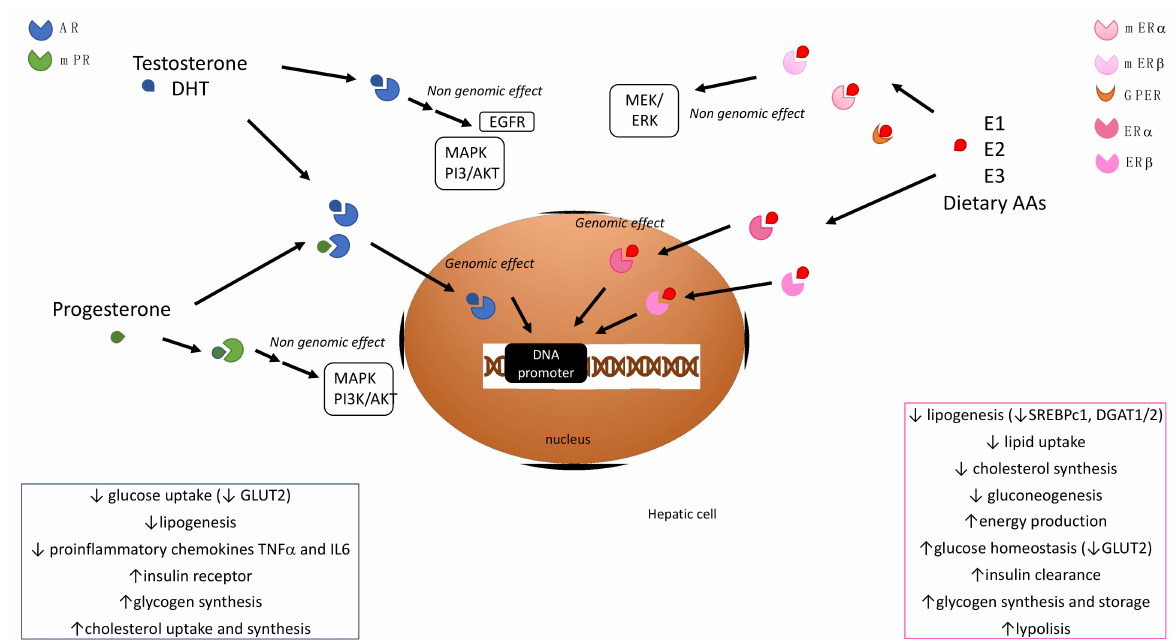
Figure 1. Main signaling pathways mediated by sex hormone receptors in hepatocytes and their physi- ological effects. AR, androgen receptor; mPR, membrane progesterone receptor; DHT, dihydrotestos- terone; MAPK, mitogen-activated protein kinase; PI3K/AKT, phosphatidylinositol 3-kinase/protein kinase B; EGFR, epidermal growth factor receptor; MEK/ERK, mitogen-activated protein kinase ki- nase/extracellular signal-regulated kinase; E1, estrone; E2, estradiol; E3, estriol; mER, membrane estrogen receptor; ER, estrogen receptor; GPER G, protein-coupled estrogen receptor 1; AA, amino acid; GLUT2, glucose transporter 2; TNF α , tumor necrosis factor α ; IL6, interleukin 6; DGAT, diacylglycerol acyltransferase; SREBPc1, sterol regulatory element binding protein